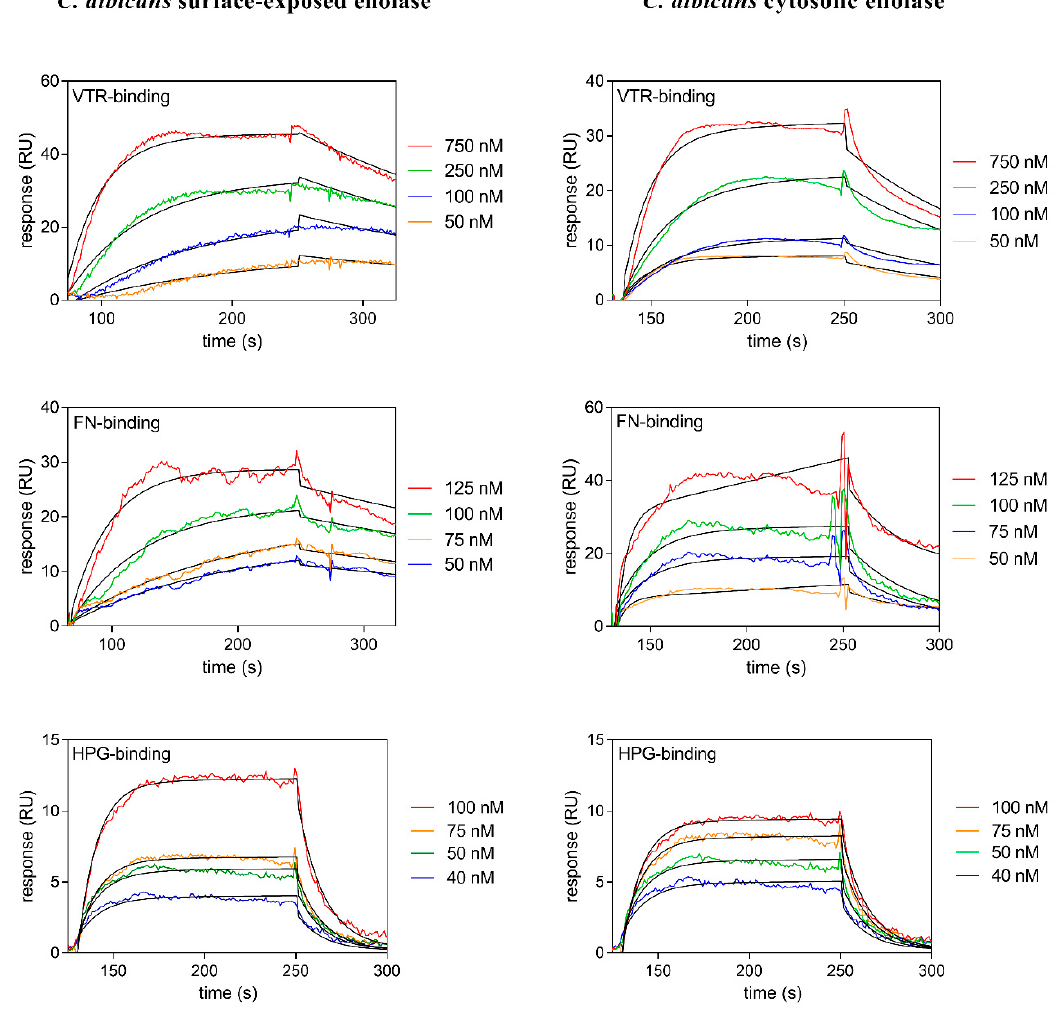
Figure 2. Surface plasmon resonance (SPR) analysis of the interactions between vitronectin (VTR), fibronectin (FN) or human plasminogen (HPG) and C. albicans enolase isolated from the cell surface or cytosol. Sensograms were obtained after the injection of human proteins (analyte concentrations were within a 40–750 nM range) over a CM5 chip containing immobilized enolase at a flow rate of 30 µL/min. A Langmuir 1:1 binding model with a baseline drift and Rmax locally was well fitted to the sensograms, as shown by the black lines. These data were collected from three independent experiments.